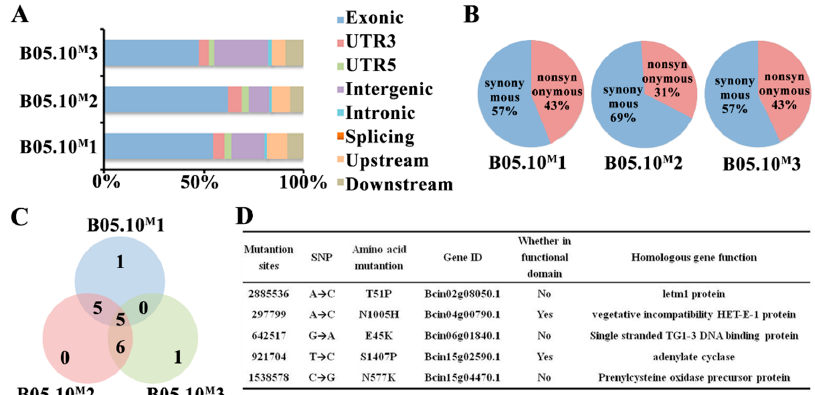
Figure 3. Whole genome resequencing analysis of B05.10 M . ( A ) Distribution of single-nucleotide polymorphisms (SNPs) in the genome. B05.10 M 1-3 show data from three independent resequencings of B05.10 M . ( B ) SNP-induced amino acid variation in the exon region. ( C ) Statistical analysis of nonsynonymous mutation in B05.10 M triple-sequencing data. ( D ) Analysis of 5 common missense mutation sites.